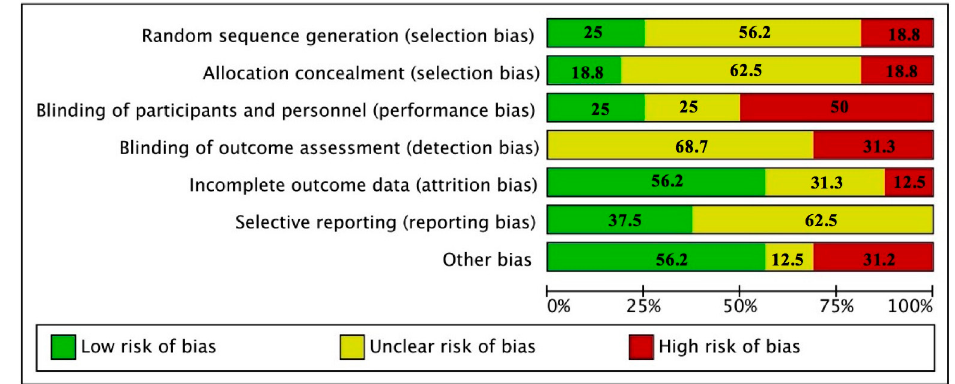
Figure 2. Report of the study quality index components in studies included .